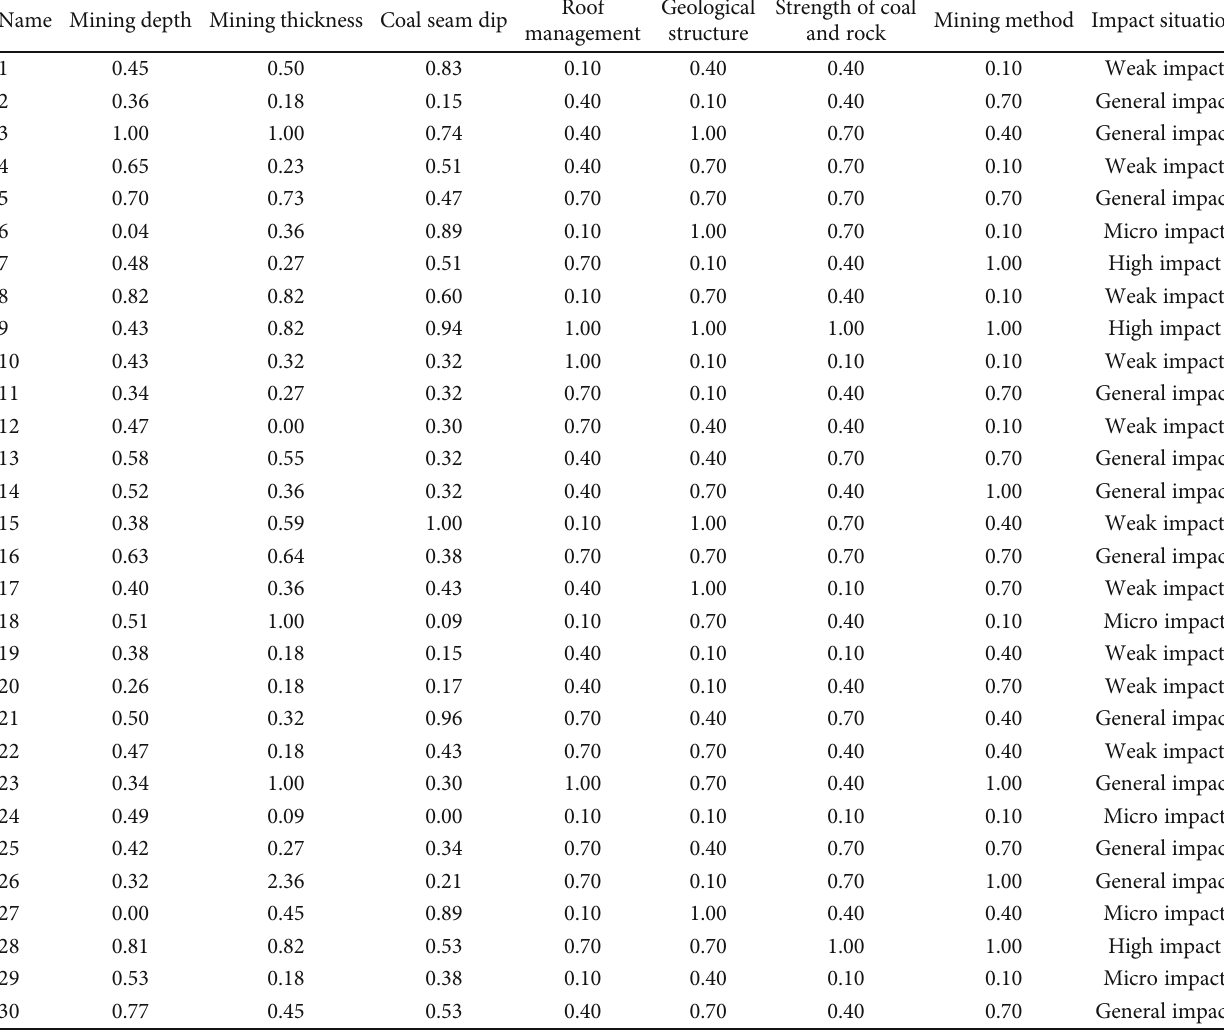
Table 2: Sample quantization table.